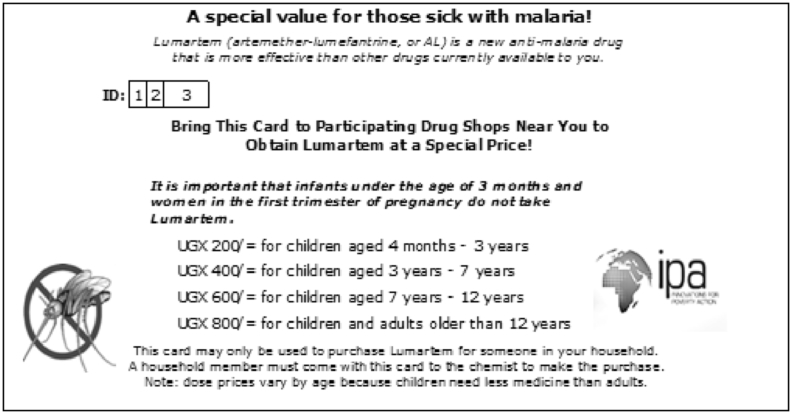
Example of Purchase ID card. Each household was given only one Purchase ID card that could be used by any member of the household as many times as they needed. The Purchase ID was used to link the drug shop and follow-up surveys for individuals to the baseline information for the household.